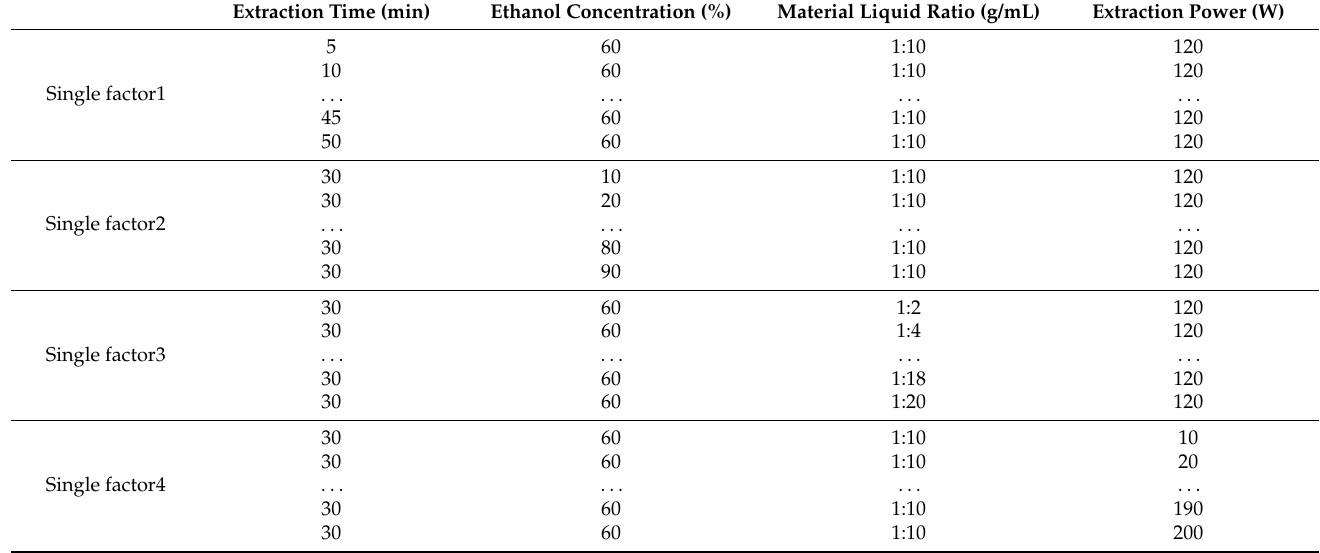
Table 1. Single factor experimental